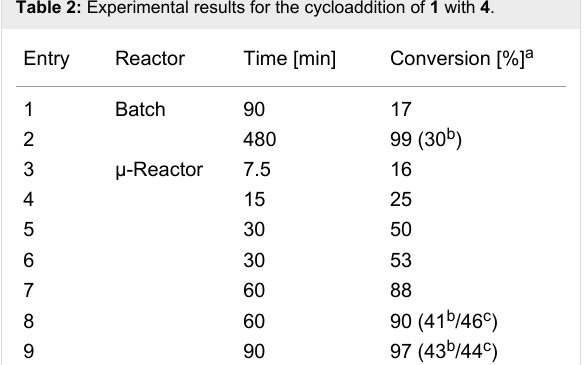
Table 2: Experimental results for the cycloaddition of 1 with 4